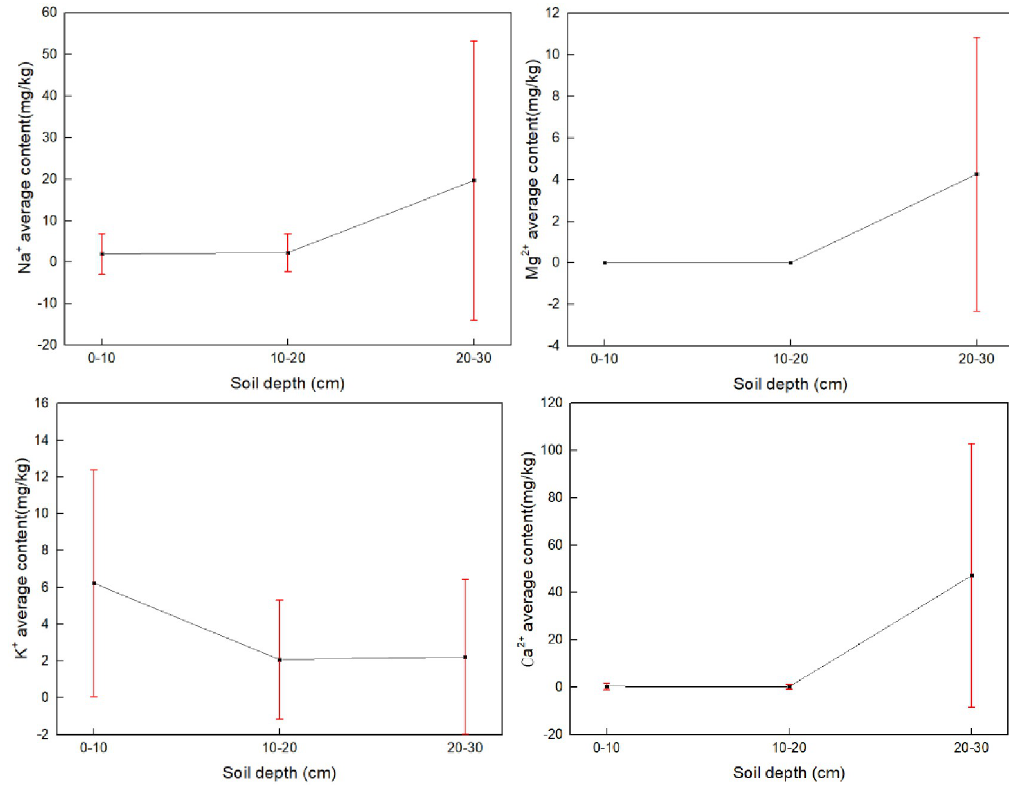
Fig 8. Base ion concentrations for different soil depths (Cartographic